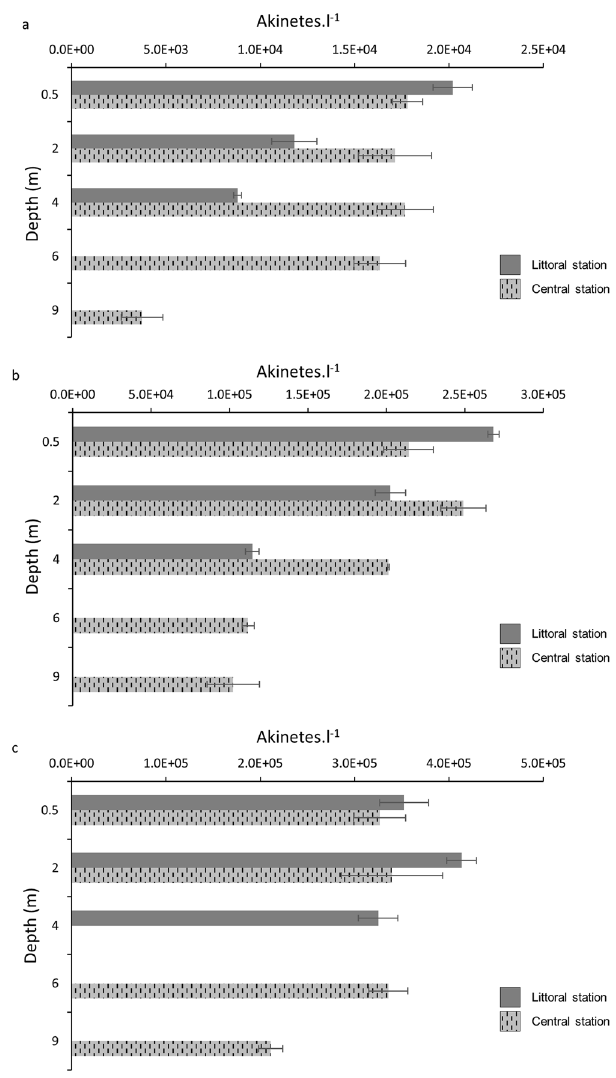
Figure 1. Abundances of mature akinetes. Data are reported for Central (hashed bars) and Littoral (solid bars) stations the 7 th ( a ), 14 th ( b ) and the 21 st ( c ) of October 2011. Error bars indicate the standard